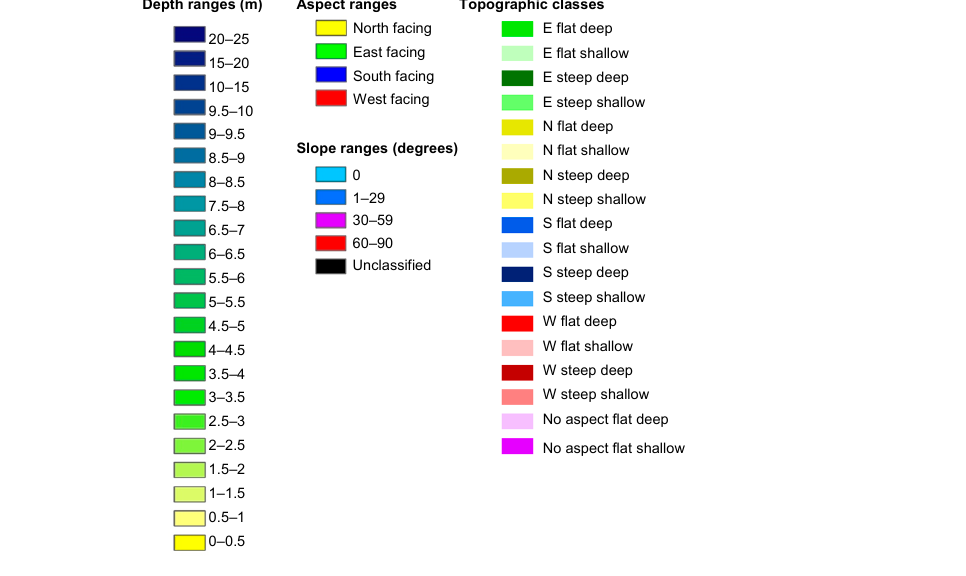
Figure 6. Legends for depth, aspect, slope, and final topographic classes at the Ningaloo Reef. This legend applies to Figures 7–9.